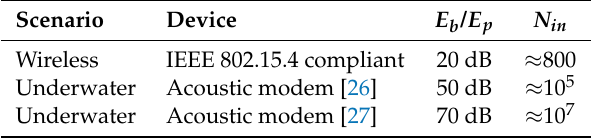
Table 3. Maximum field size N in s.t. D in = 1 for different IoT network technologies.